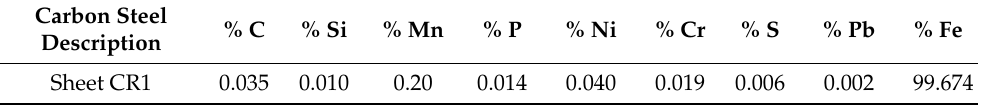
Table 1. Composition of Carbon Steel